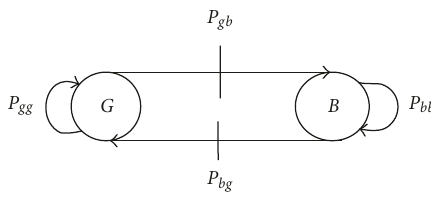
Figure 5: Two-state Markov process